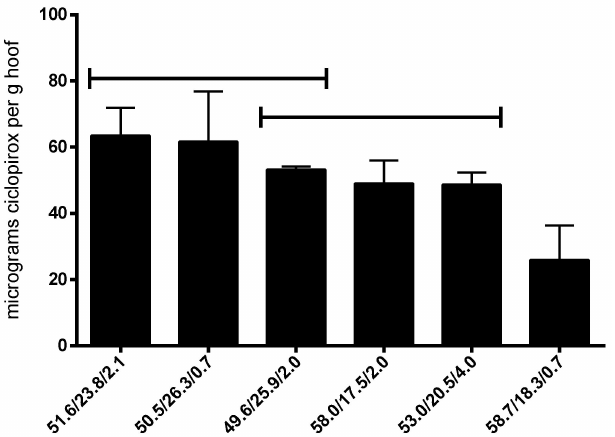
Figure 5. Amount of ciclopirox base found in the hoof after 11 days of the di ff usion experiment. Black lines represent homogeneous groups (one-way ANOVA and Tukey test, α <